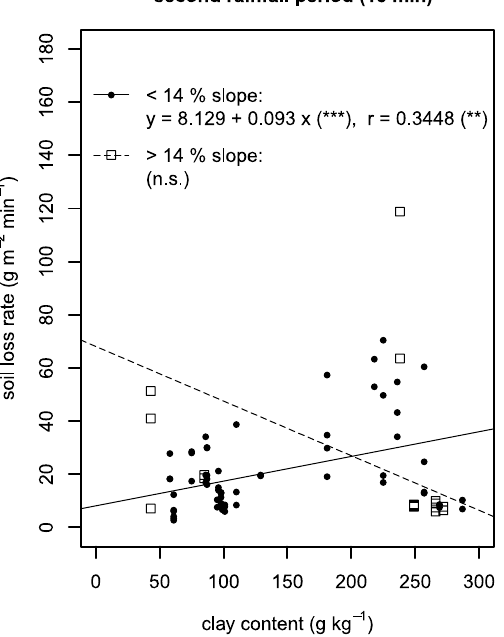
Figure 5. Simple linear regression of the soil loss rate in the second rainfall period (15 min) against the clay content. For each parameter fitting, generalized linear models assuming a Gamma distribu- tion have been applied. The regression function and Pearson product–moment correlation coeffi- cient ( r ) are given for the significant parameter fitting. The significance levels of the regression func- tion slope and r , indicating a difference from zero, are as follows: (***) p < 0.001; (**) p < 0.01; (n.s.) not significantly different at p < 0.05.